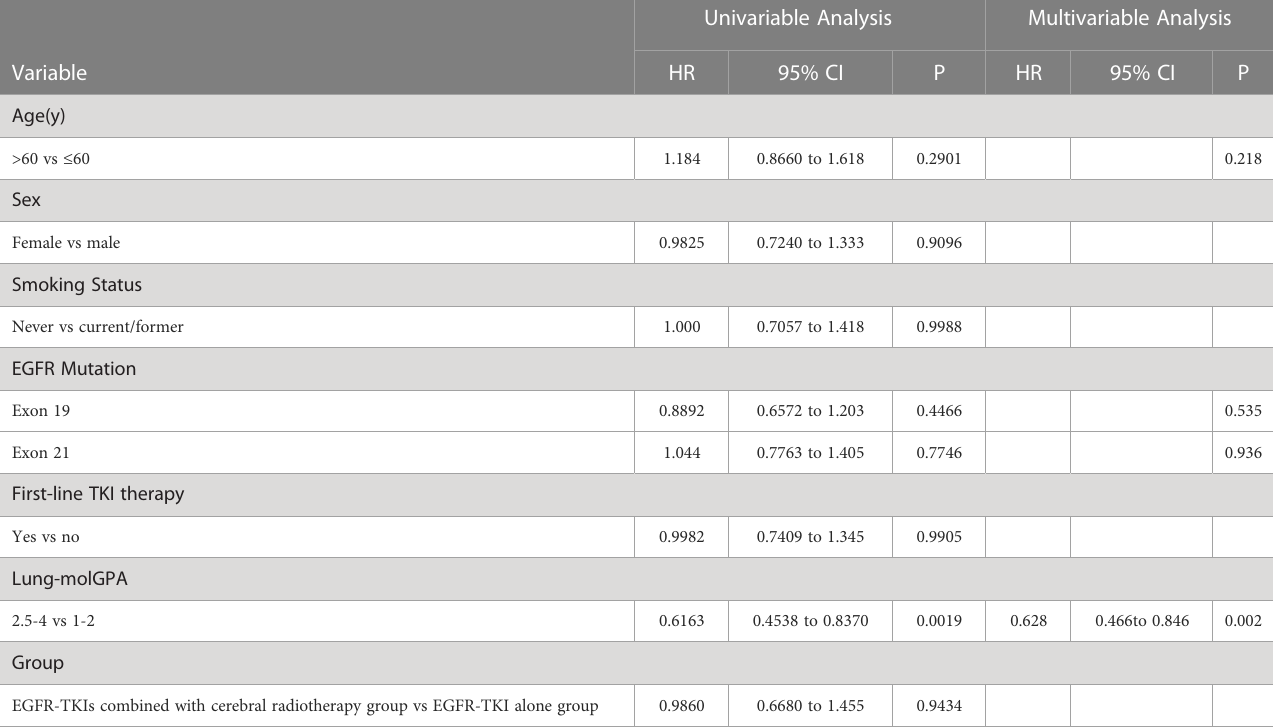
TABLE 3 Univariable and multivariable analyses of covariables associated with pfs.